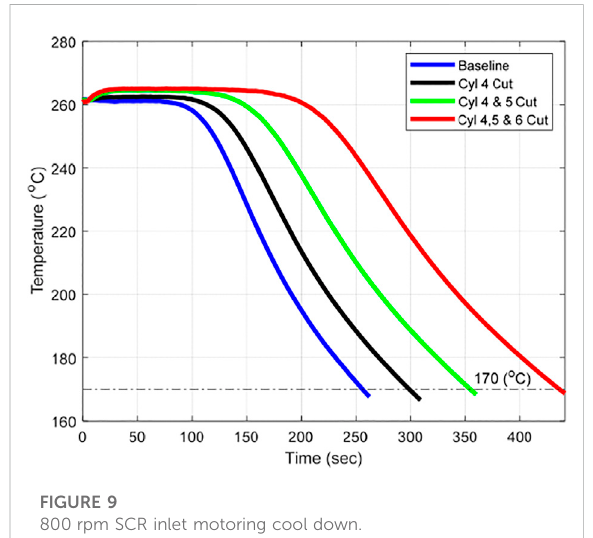
FIGURE 9 800 rpm SCR inlet motoring cool down.